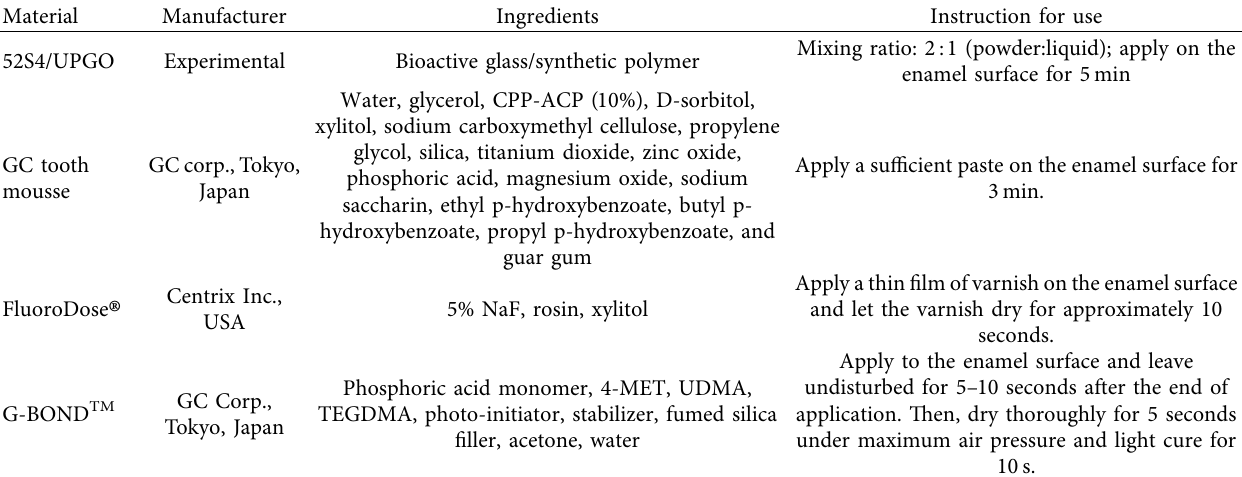
Table 2: Instruction for use and composition of remineralizing agents.